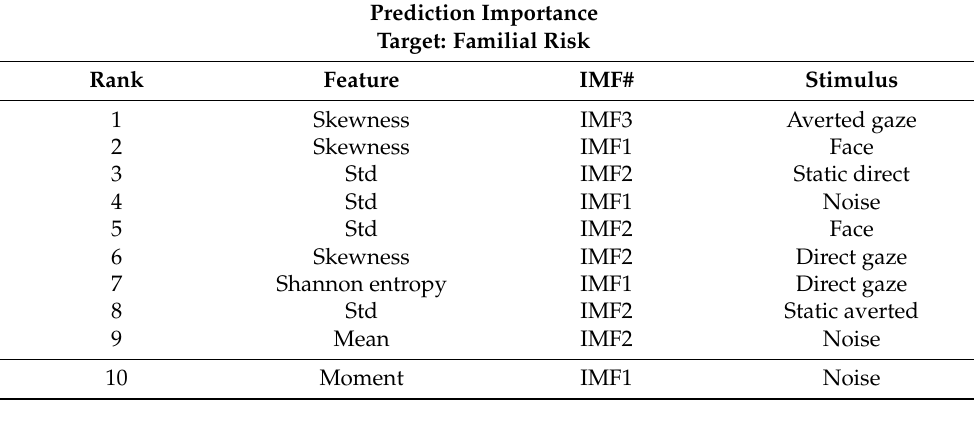
Table 5. Ranked predictor importance for the k -NN classifier predicting familial risk from six features and six averaged epochs.